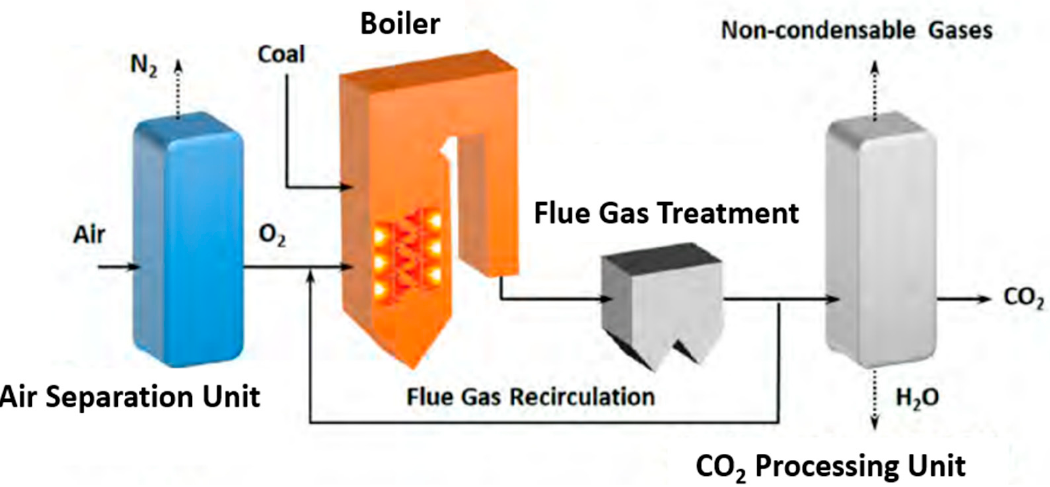
Figure 2. Oxyfuel combustion technology. Source: Technical Report of State of the Art: CCS Technologies 2022. Global CCS Institute.